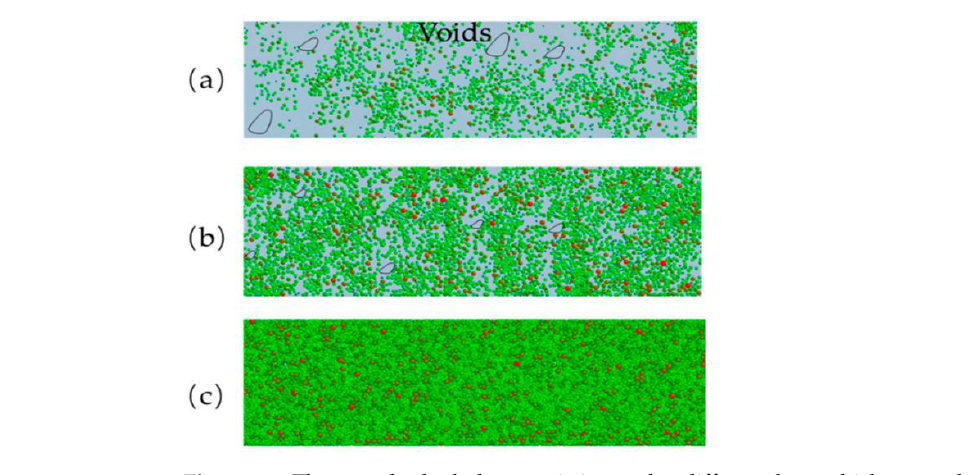
Figure 8. The powder-bed characteristics under different layer thickness values: ( a ) H = 50 μm; ( b )H